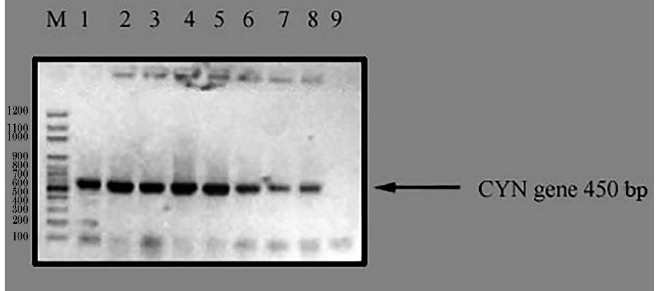
Figure 5. Colony PCR test of CYN transgenic algae. M: 100 bps DNA ladder; Lane 1: CYN positive control (transgenic C. reinhardtii contaiing CYN gene ) ; Lane 2, 3, 4, 5, 6, 7, 8: transgenic C. reinhardtii algae tested with PCR system for CYN gene; and Lane 9: negative control (wild C. reinhardtii) .